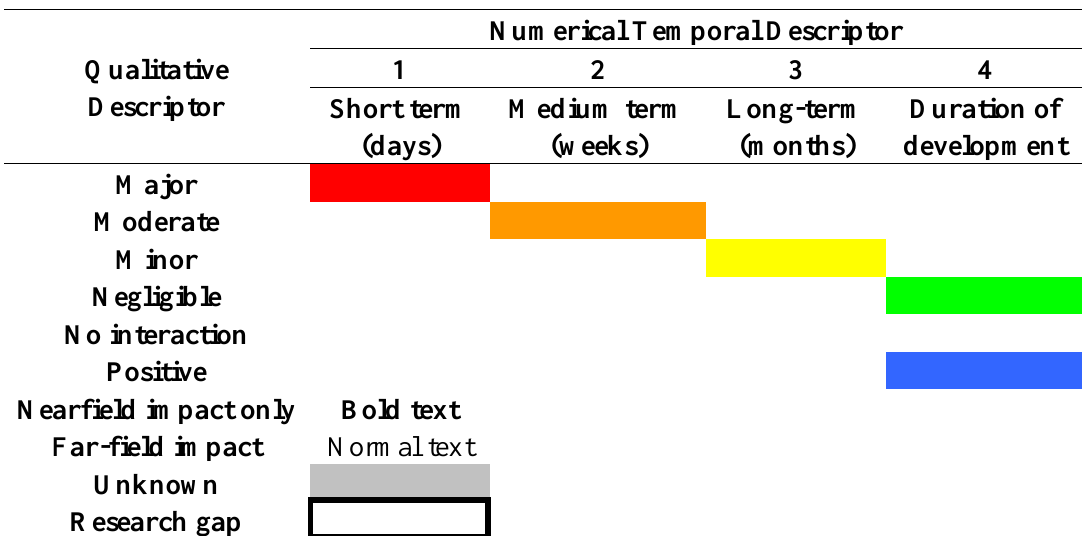
Table 2. Summary of assessment criteria used to establish the significance of geo-environmental